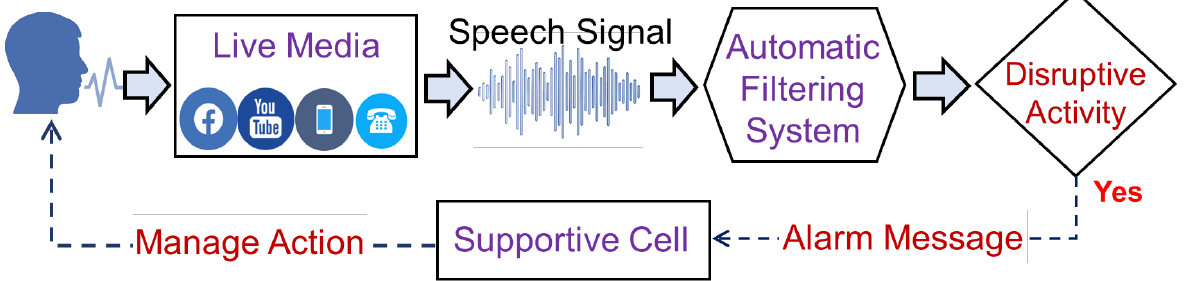
Figure 1. A supportive system framework through automatic filtering of disruptive activity from speech signal of live media.